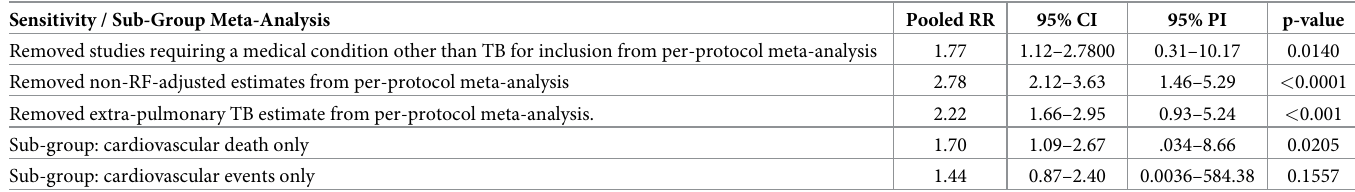
Table 3. Sensitivity and sub-group random effects meta-analyses of tuberculosis and risk of cardiovascular disease and related mortality. Sensitivity / Sub-Group